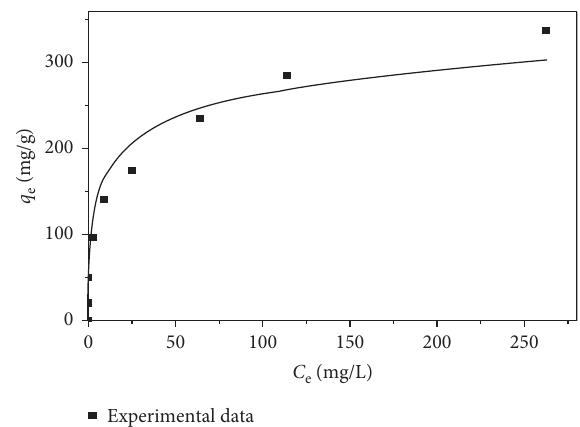
Figure 7: Nonlinear fit of the Temkin isotherm for MO adsorption onto activated carbon ( t contact � 2 h; adsorbent dose � 1g/L; pH ∼ 7; T � 20 ° C).